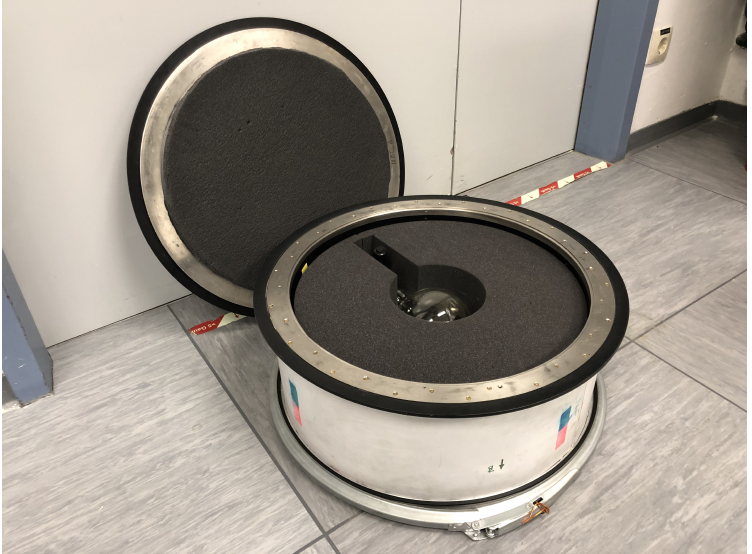
Figure 5. Magnetic transport box [18] with a single glass ball for polarized 3 He gas. Alternatively, boxes are available that can accommodate three glass balls at the same